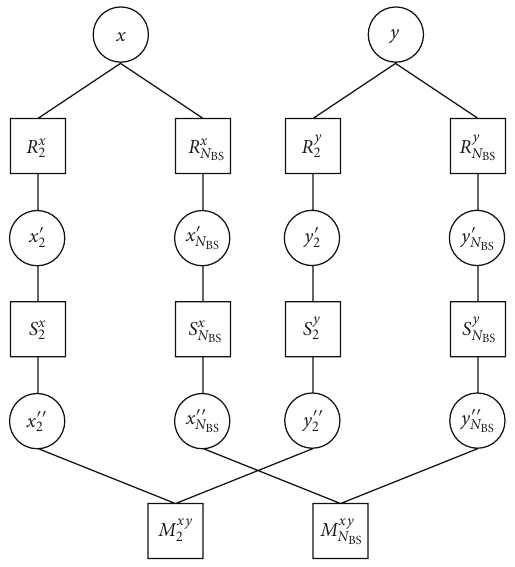
Figure 5: Factor graph for TDoA